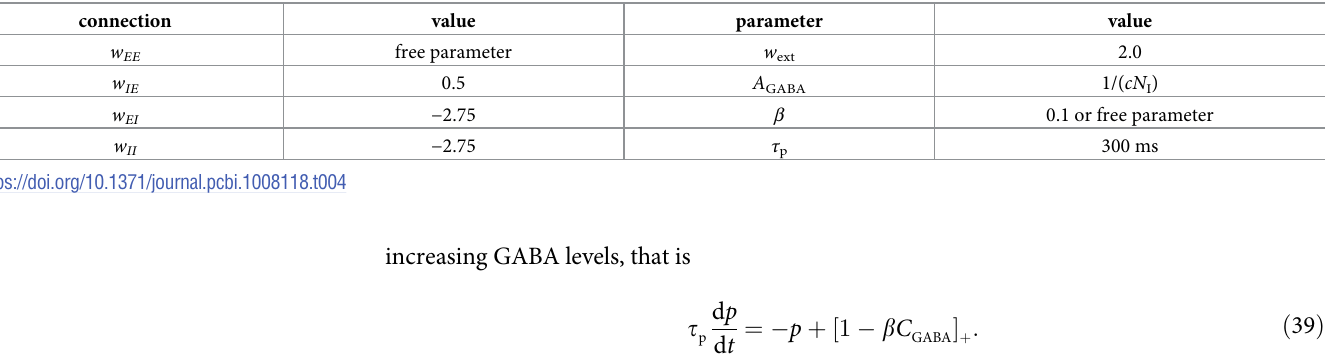
Table 4. Synaptic connection and spillover